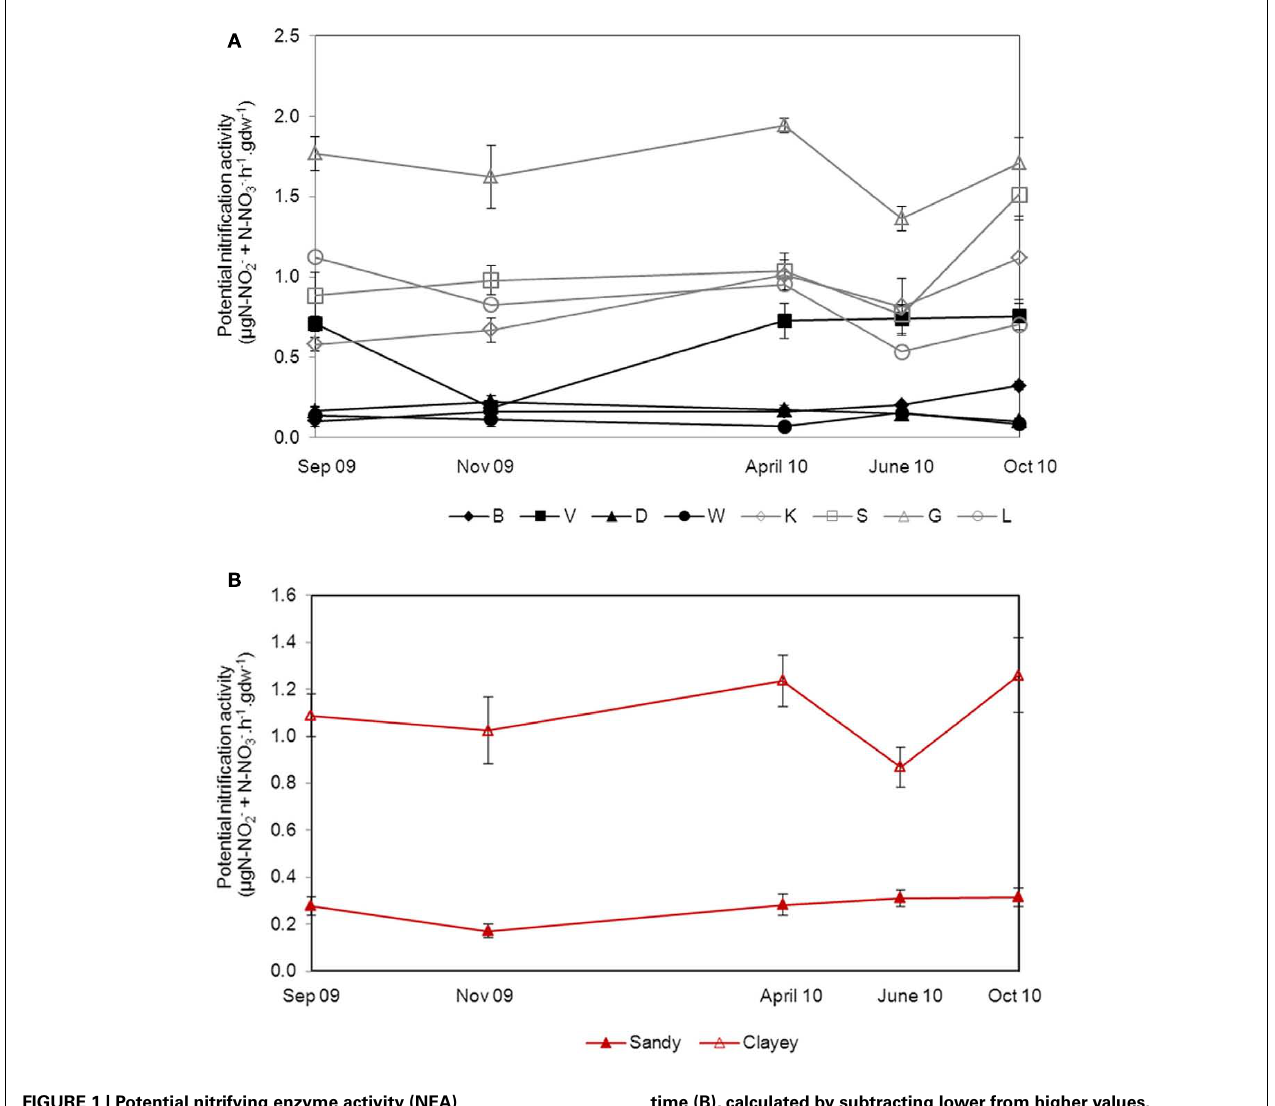
time (B), calculated by subtracting lower from higher values. Soil names are: B, Buinen;V,Valthermond; D, Droevendaal;W, Wildekamp; K, Kollumerwaard; S, Steenharst; G, Grebbedijk; and L, Lelystad. Bars are SE ( n = 4). Black symbols: sandy soils; gray symbols, clayey